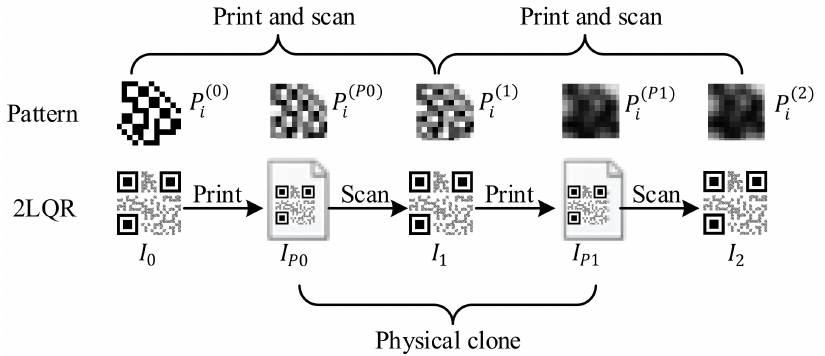
Figure 6. The physical cloning process of a 2LQR code and a textured